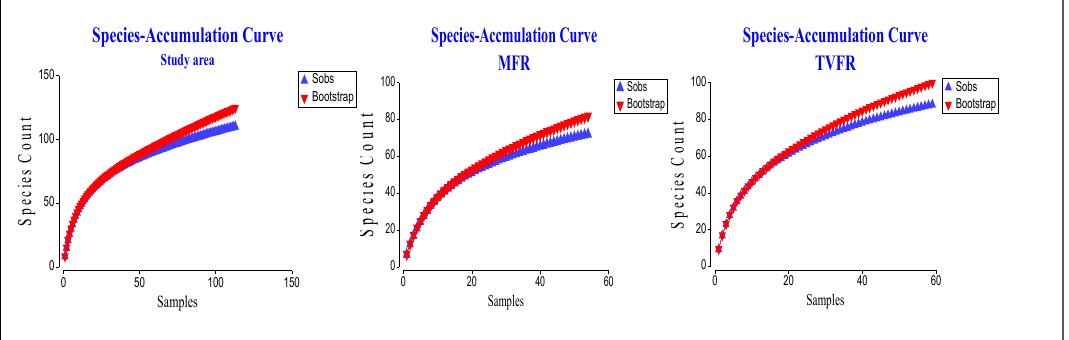
= Mafhela Forest Reserve,